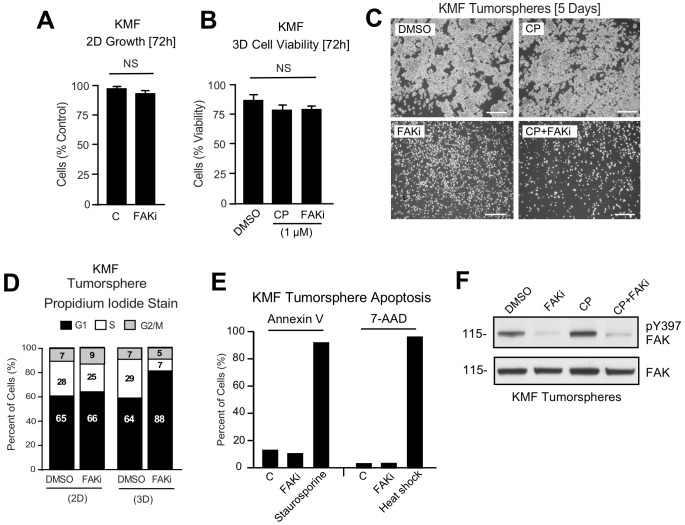
Small molecule FAK inhibition prevents KMF 3D tumorsphere proliferation with effects on cell cycle but not cell apoptosis.(A) Growth of KMF cells in 2D culture + /- FAKi (VS-4718, 1 µM) over 72 hr. (B) Cell viability (trypan blue exclusion) of KMF cells grown in 3D (PromoCell) in the presence of DMSO, cisplatin (CP, 1 µM), or FAKi (1 µM). (A and B) Values are means + /- SD. NS, not significant. (C) Representative images of KMF cell tumorsphere formation (PromoCell, 5 days) in DMSO, cisplatin (CP, 1 µM), FAKi (1 µM), or CP plus FAKi (1 µM each). Scale is 1 mm. (D) KMF cells grown in 2D or 3D as tumorspheres for 3 days, treated with DMSO or FAKi (VS-4718, 1.0 µM), stained with propidium iodide, and analyzed by flow cytometry. Percentage of cells in G0, G0/G1, S, and G2/M phase of the cell cycle was determined using FlowJo. (E) Percent of KMF tumorsphere cell staining for annexin V or 7-AAD (7-aminoactinomycin D) treated with DMSO (control, (C), FAKi (VS-4718, 1 µM 24 hr), staurosporine (1 µM, 24 hr), or heat shock (100°C, 15 min) by flow cytometry. (D and E) Values are means from two independent experiments. (F) KMF cells grown as 3D tumorspheres for 3 days were treated with DMSO, FAKi (VS-4718, 1.0 µM), cisplatin (CP, 1 µM), or CP plus FAKi (1 µM each) for 2 hr and lysates evaluated by FAK and pY397 FAK immunoblotting.